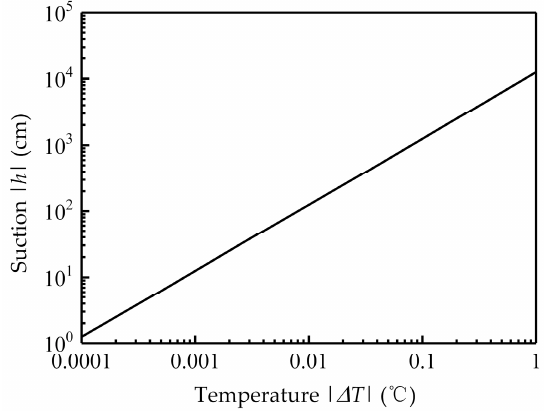
Figure 13. Relationship between the hydraulic head and temperature for frozen soil estimated using the Clausius-Clapeyron equation.